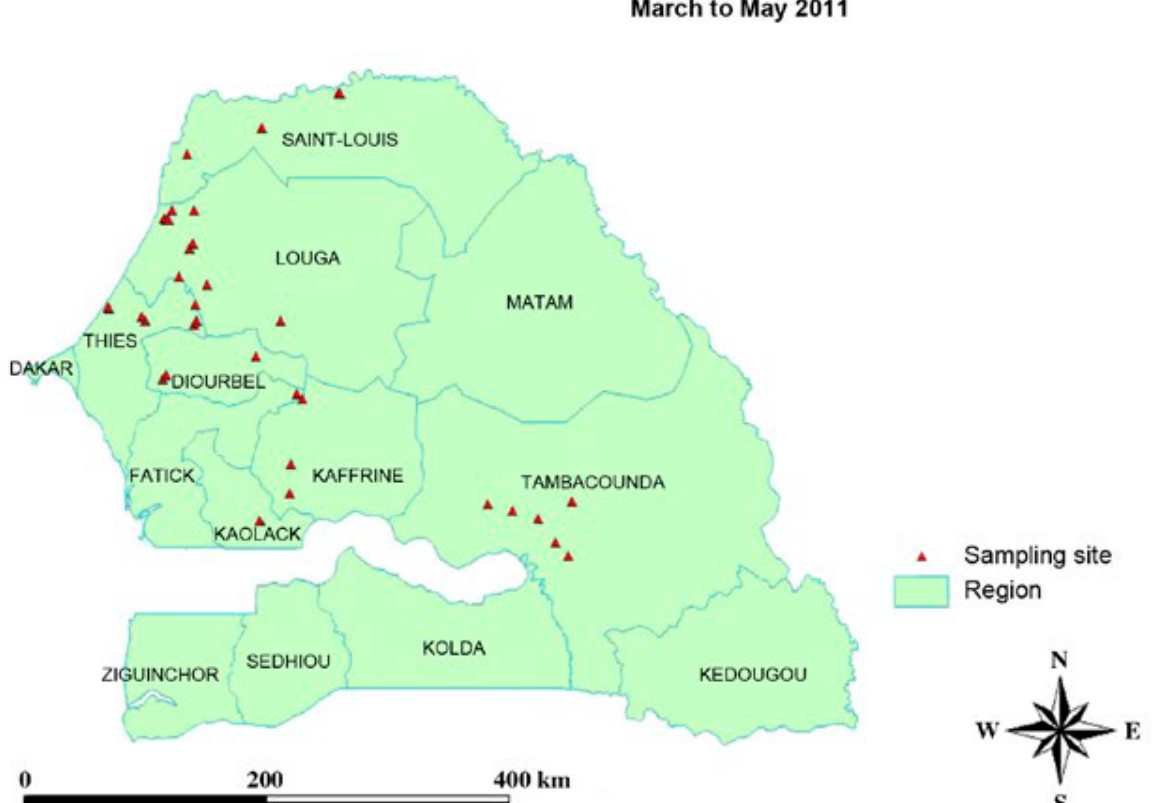
Figure 2. Senegalese cities where samples of different hosts of Macrophomina strains were